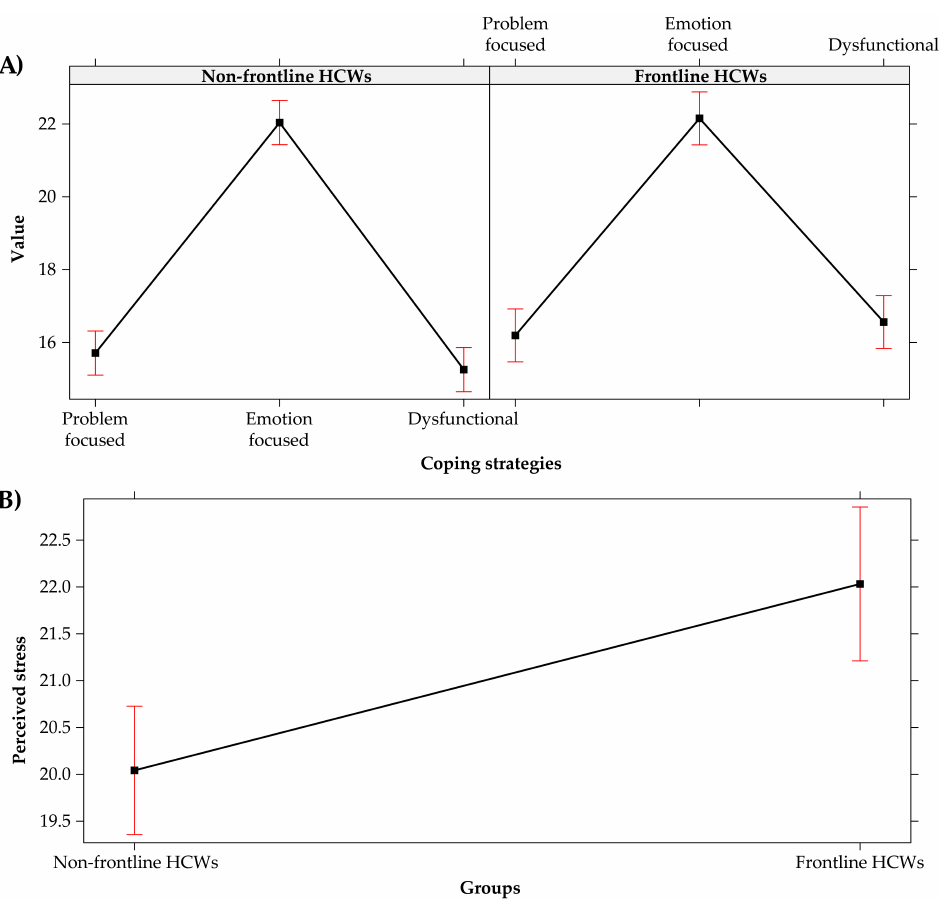
Figure 3. Effect plot of: ( A ) coping strategies; ( B ) perceived stress of groups. The bars represent the 95%